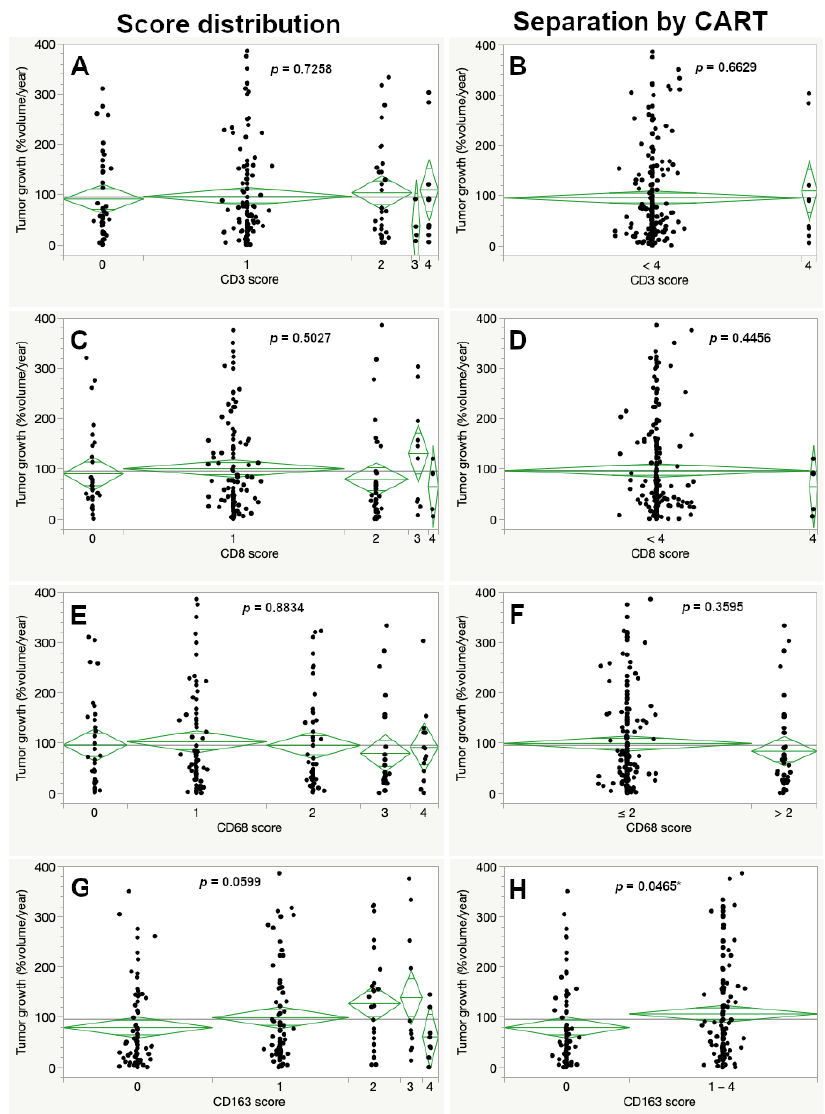
Figure 4. Percentual volumetric tumor growth according to the immunohistochemical expression for the complete immunohistochemistry score (left images) and the CART-specific cut-off (right im- ages) for CD3 ( A , B ), CD8 ( C , D ), CD68 ( E , F ) and CD163 ( G , H ). No significant differences in